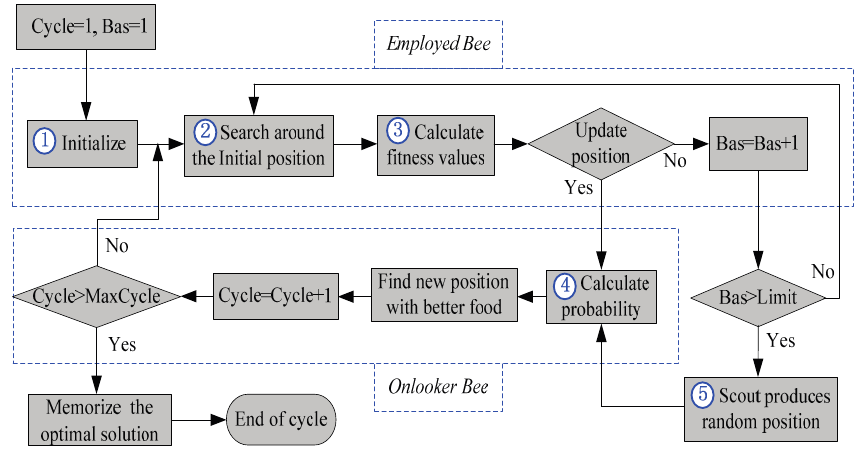
Figure 2. Flowchart of basic ABC